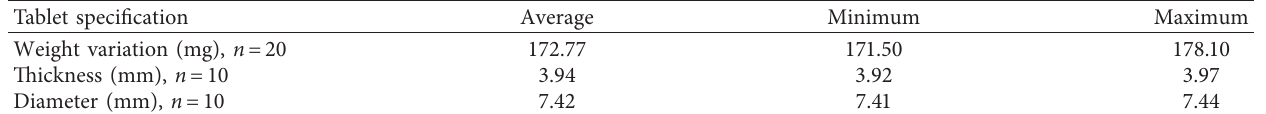
Figure 4: Design of SRP tablet and analyzed by UV spectroscopy. Table 9: Assessment of weight variation, thickness, and diameter.